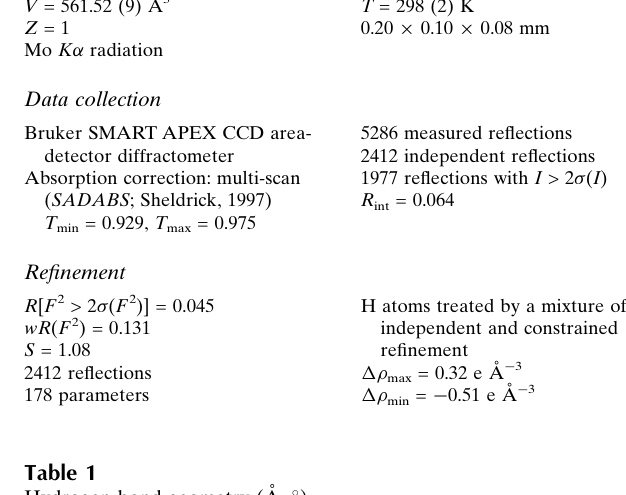
Hydrogen-bond geometry (A˚ , (cid:3)